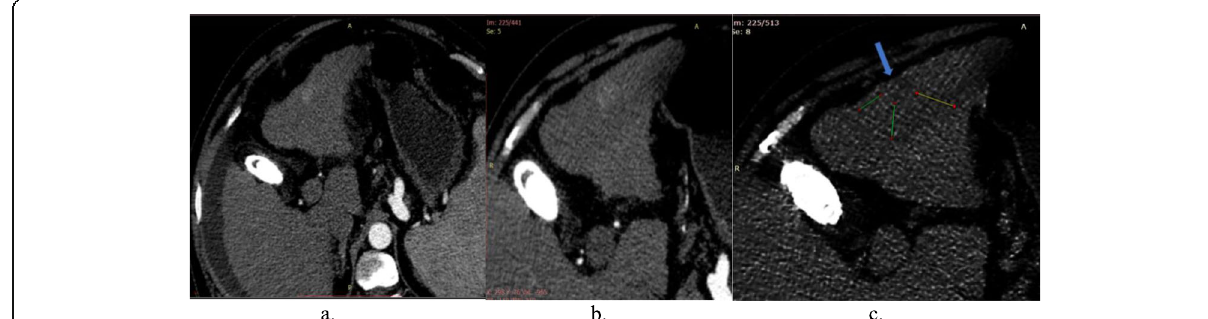
Fig. 6 Case 3: a 55-year-old male patient with cirrhosis. a MDCT in the arterial phase dated August 2016 reveals a small left lobe hyper-enhancing nodule measuring 11 mm showing no washout in the venous nor the delayed phases (not shown); this lesion is categorized as LIRADS-3. b , c MDCT in the arterial and delayed phases for the same patient 4 months later showing size progression of the lesion measuring 22 mm with development of mild washout; in the second study, the lesion is classified as LI-RADS 5